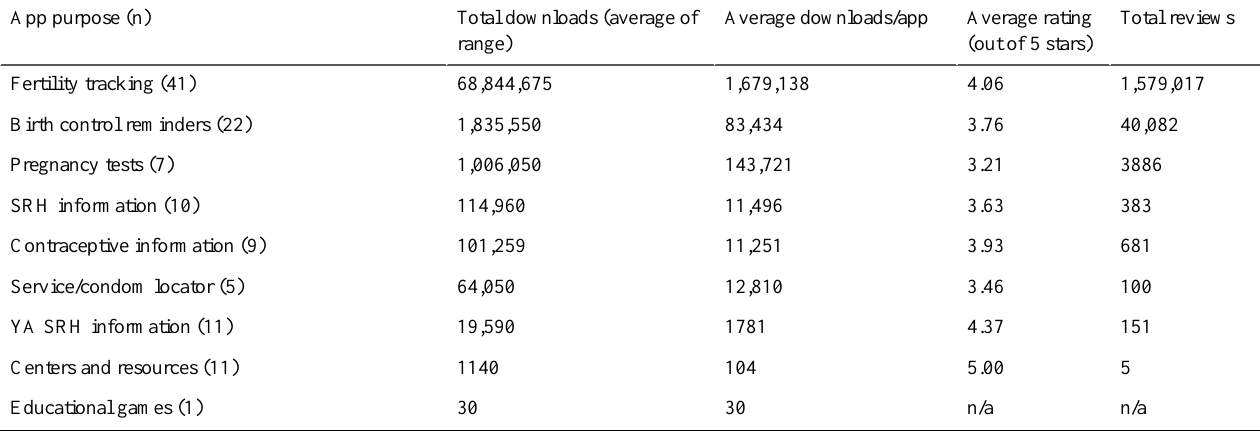
Table 4. App use and rating information from Google Play apps a